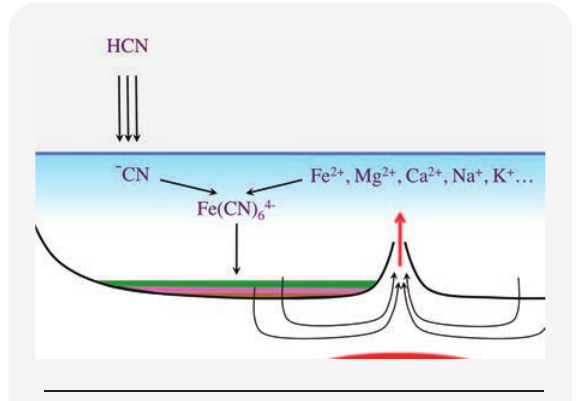
Figure 3. Geochemical scenario for accumulation of a ferrocyanide reservoir. Cyanide generated in the atmosphere rains out into lakes where it react with Fe 2 + ions brought to the surface by hydrothermal circulation of water through fractured rocks. Certain ferrocyanide salts are insoluble and precipitate, building up large reservoirs of cyanide complexes over time.